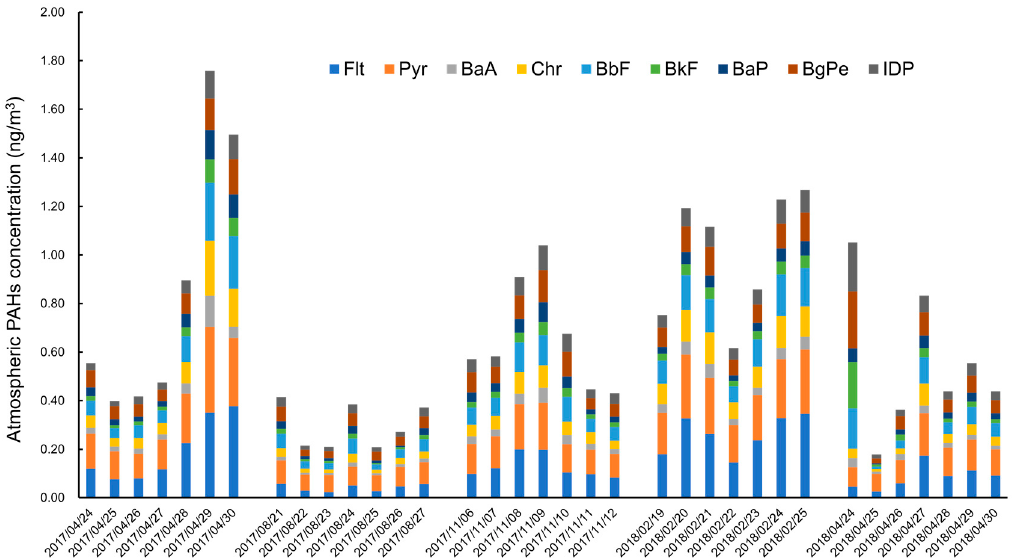
Figure 1. Daily atmospheric concentrations of PAHs in April, August, and November 2017, and February and April 2018 in Kanazawa.